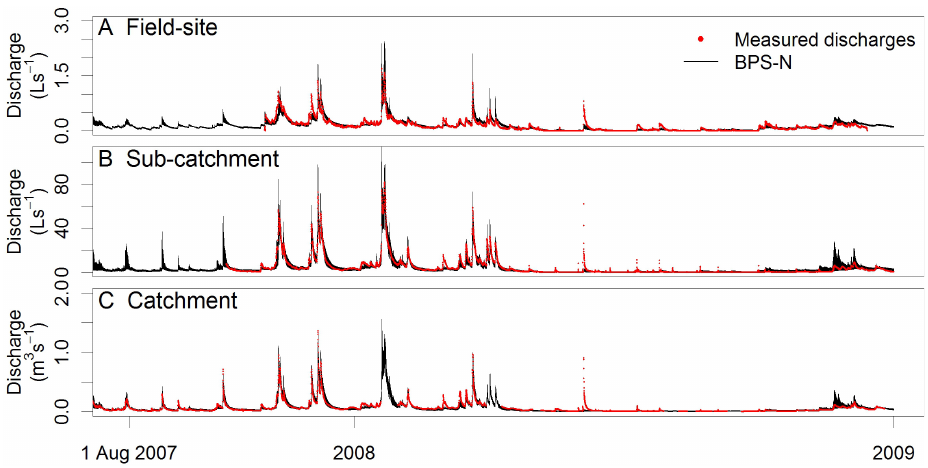
Fig. 6. Measurements and simulation results the nested-scales model for total discharges of the field-site (A) , sub-catchment (B) and entire catchment (C) . The black band gives the results of all behavioral parameter sets (BPS-N).